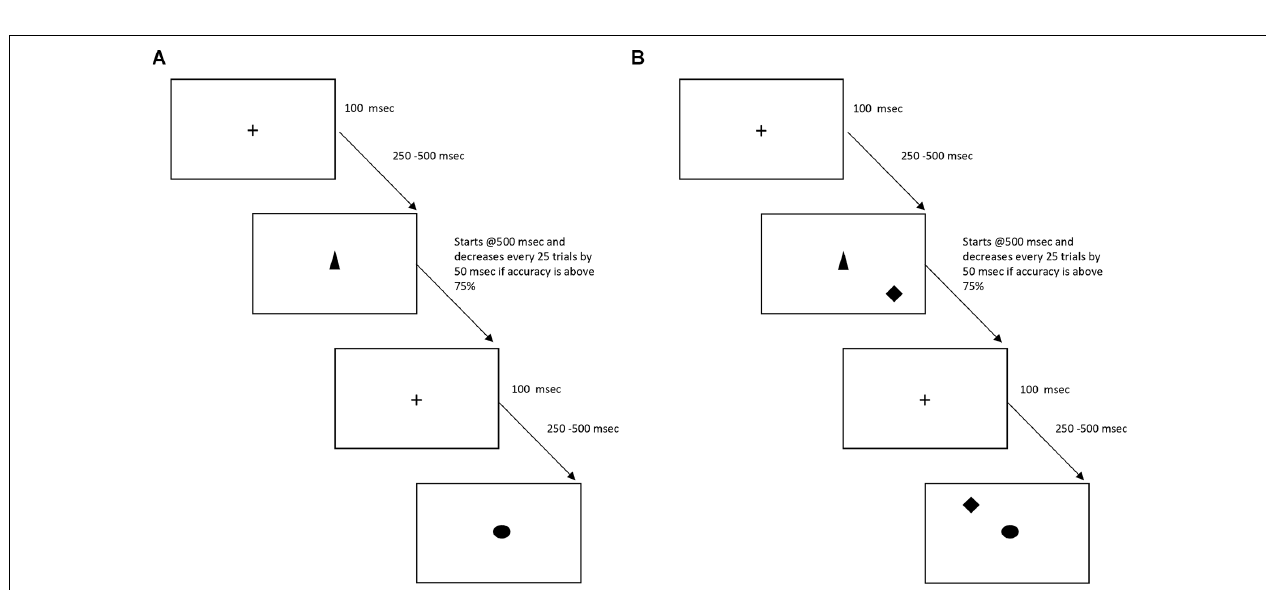
FIGURE 2 | Schematic representation of the two first conditions of the Speed of Processing (SoP) task. Panel (A) represents condition 1, with only one target. Panel (B) represents condition 2, in which a second target is added (i.e.,